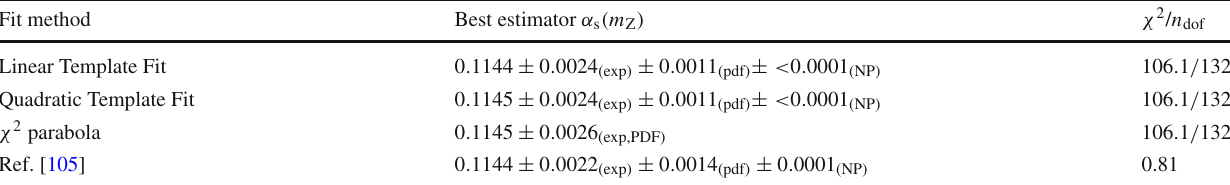
Table 2 Results from a Linear Template Fit with relative uncertainties where NLO pQCD predictions using the NNPDF3.0 PDF set are fitted to CMS inclusive jet cross section data. The results are compared with the Quadratic Template Fit and to the analytic calculation of the mini- mum of the χ 2 parabola, as well as to previously published results in the